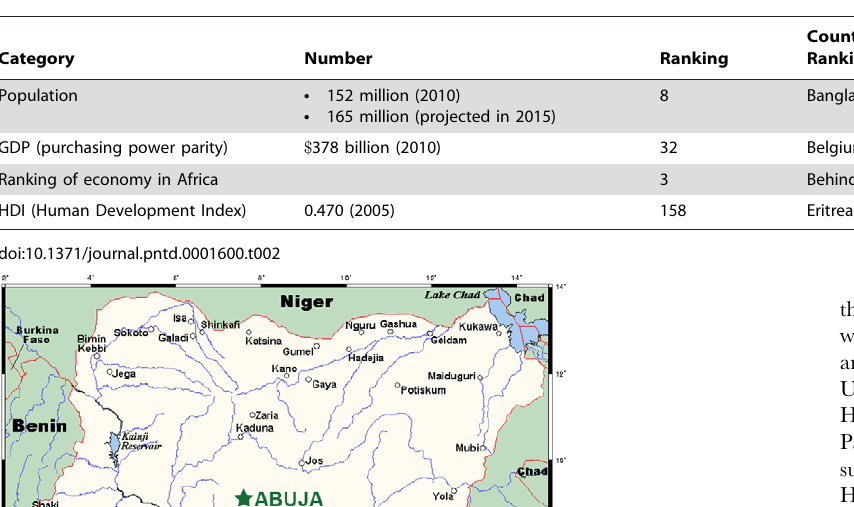
Table 2. Facts and figures about Nigeria.